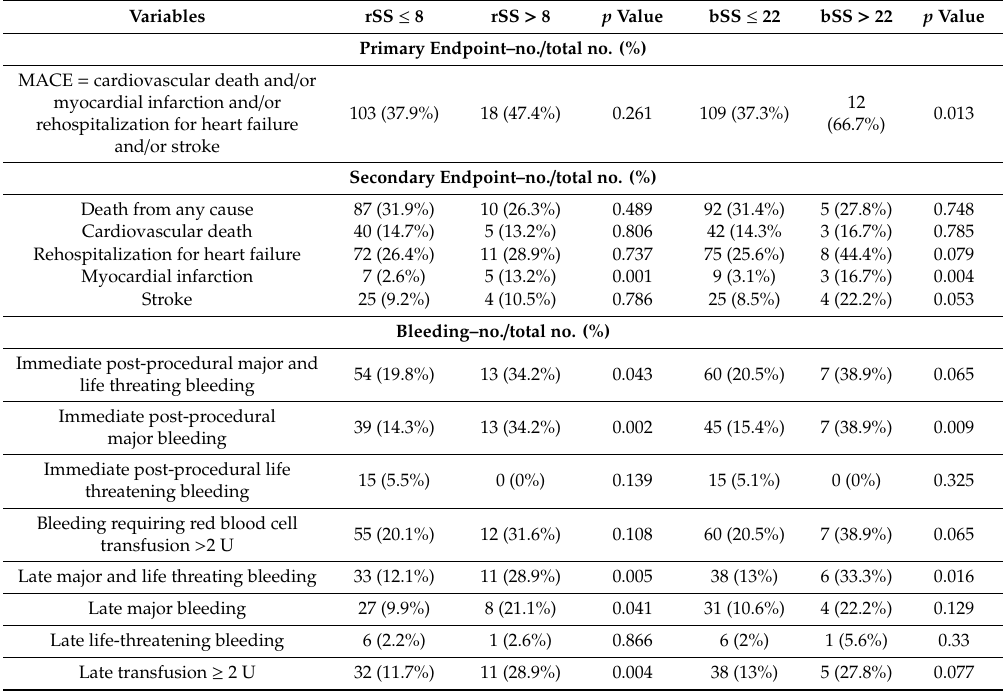
Table 3. Primary and secondary endpoints according to residual SYNTAX score (rSS) and baseline SYNTAX score (bSS).